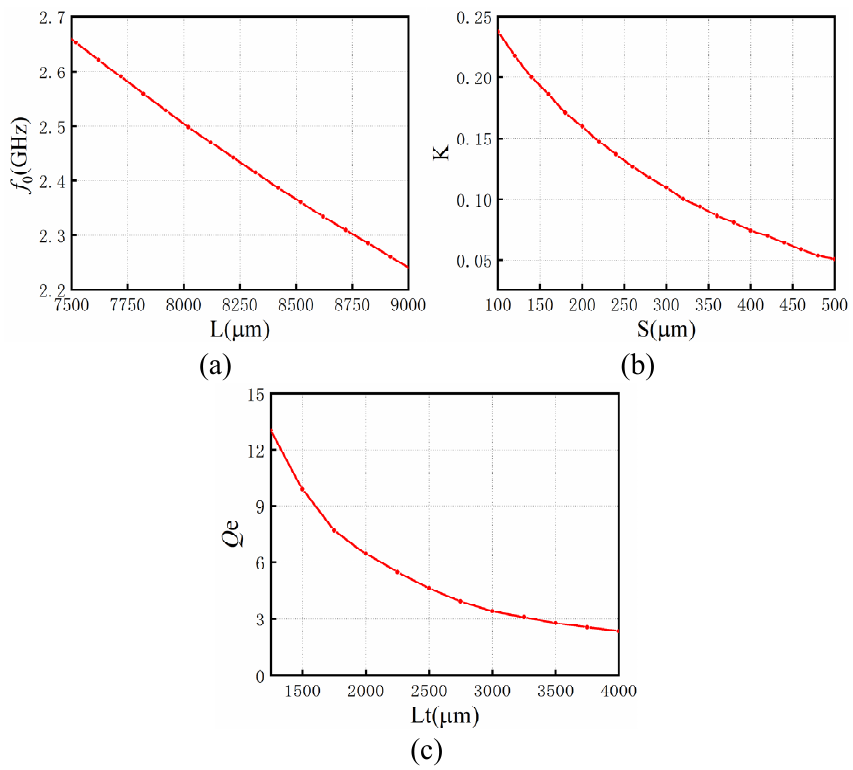
Figure 5. ( a ) Relationship between center frequency f 0 and resonator length L. ( b ) Relationship between coupling coefficient K and distance S. ( c ) Relationship between external quality factor Qe and tapped position Lt.